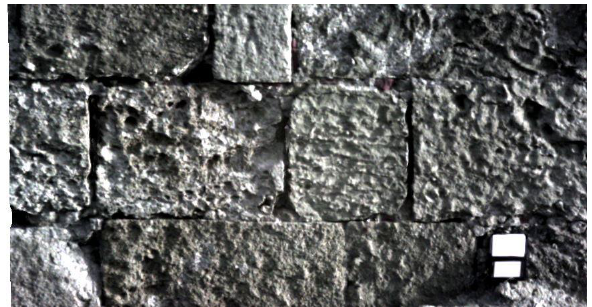
Figure 5 . Detailed 3D Textured Model using HS bands 625 nm, 540 nm, 489 nm as RGB.